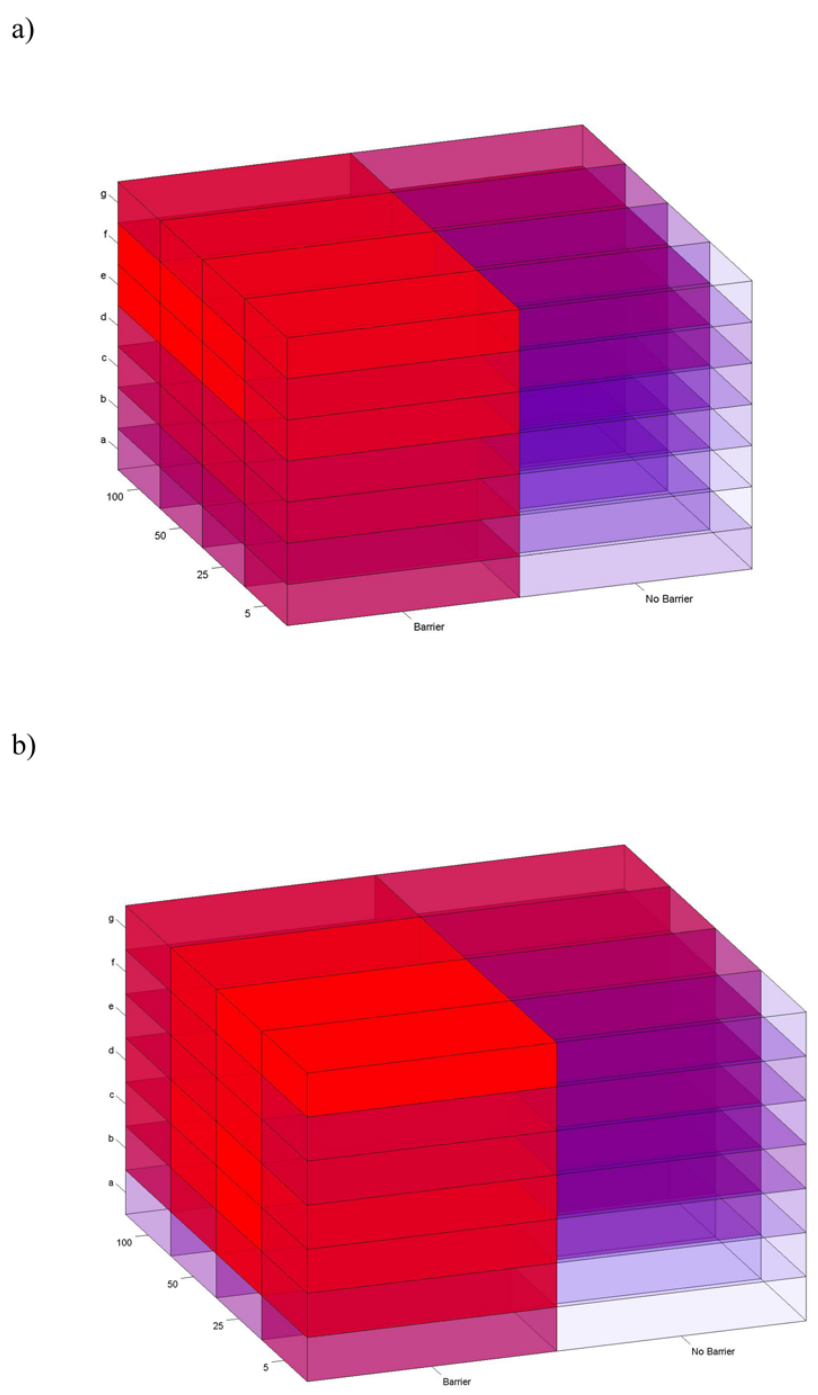
Figure 3. Factorial hypothesis cube randomization. Visualization of the 56 binary landscape-resistance hypotheses after the effects of geographical distance are partialed out on the a) log transformed and b) untransformed cost distances. The cubes each represent one of the 56 binary landscape-resistance models. The cubes are colored in a gradient from blue to red, with red being the most supported models based on the partial Mantel r value. The Mantel r values corresponding to each cube are found in Table 2 and Table S3 for the log transformed and the untransformed matrices, respectively.